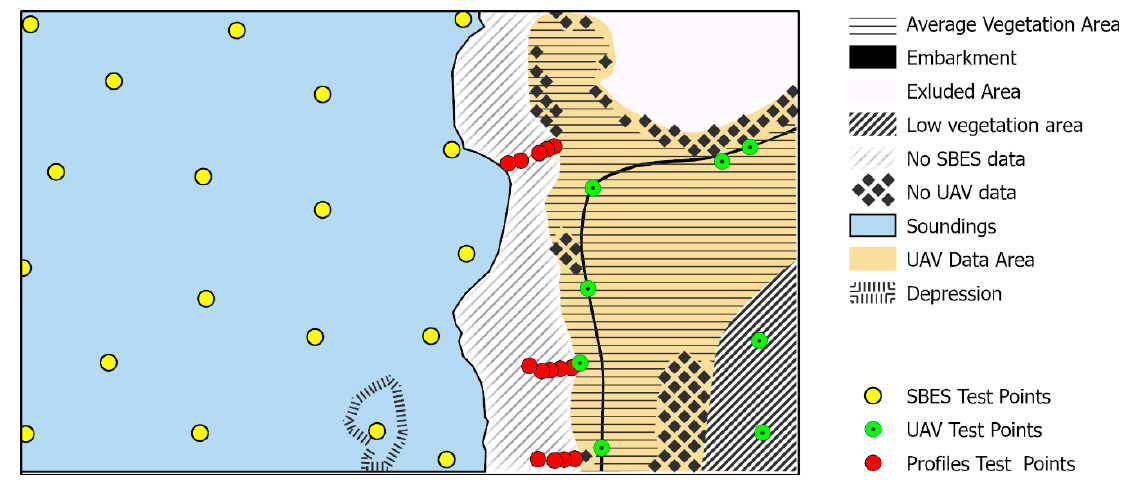
Figure 4. Analyzed test areas.